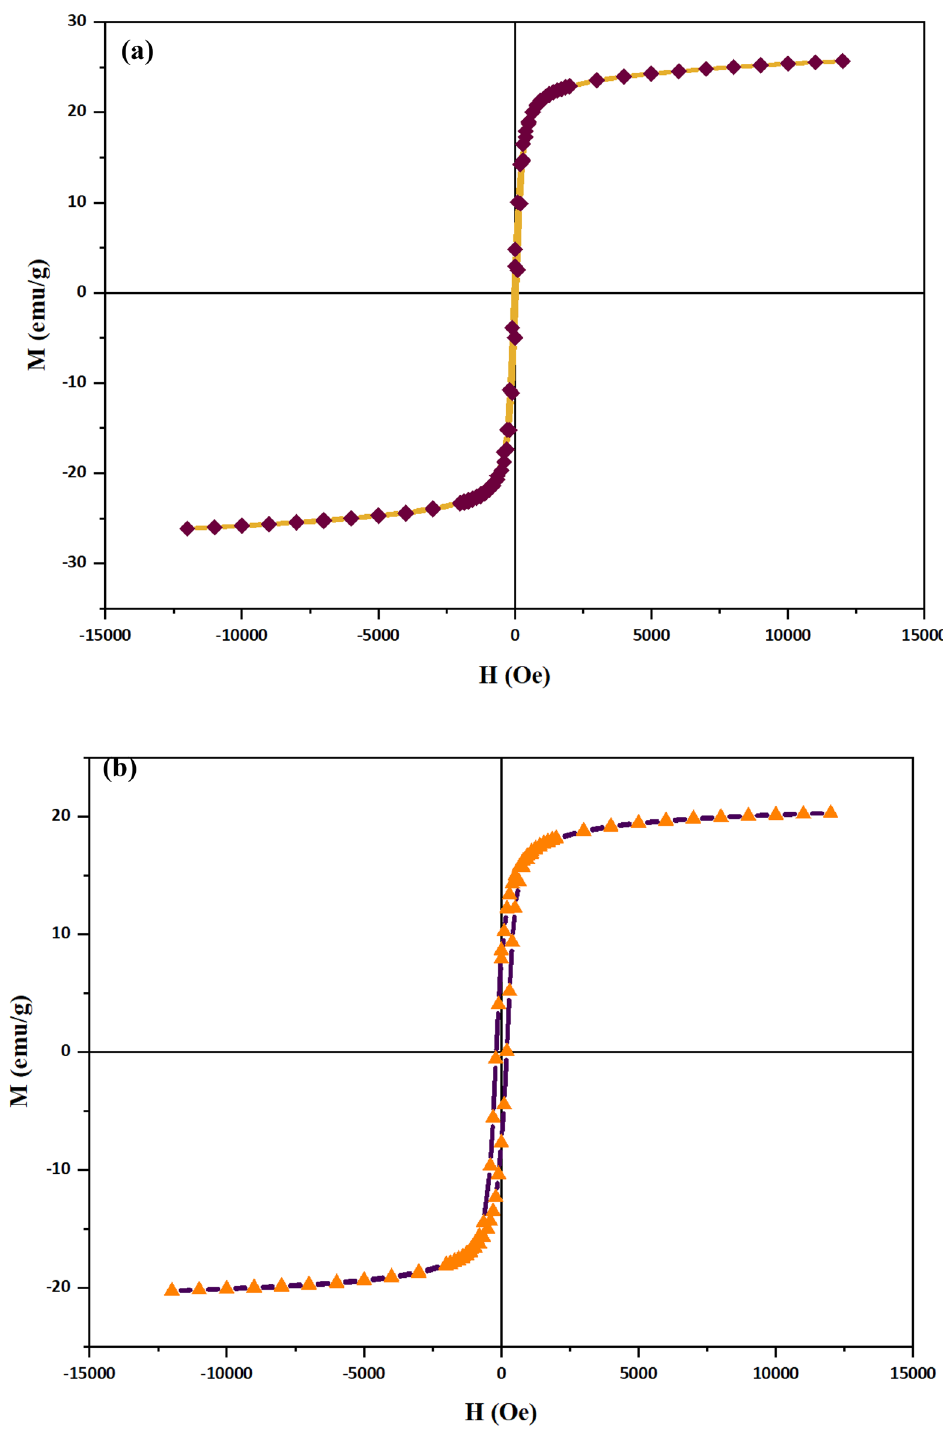
Figure 8. VSM curve of ( a ) CuFe 2 O 4 nanoparticles, ( b ) CuFe 2 O 4 @CQD nanocomposite.